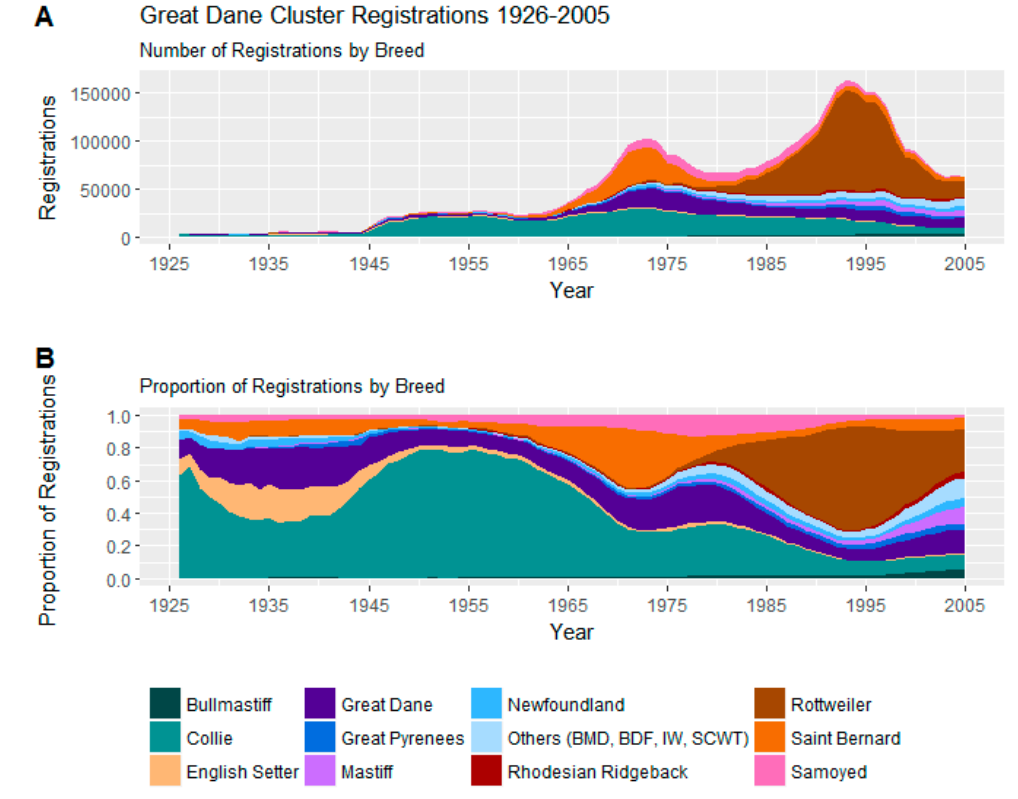
Figure 6. ( A ) Number of registrations; ( B ) and proportion of registrations within the Great Dane